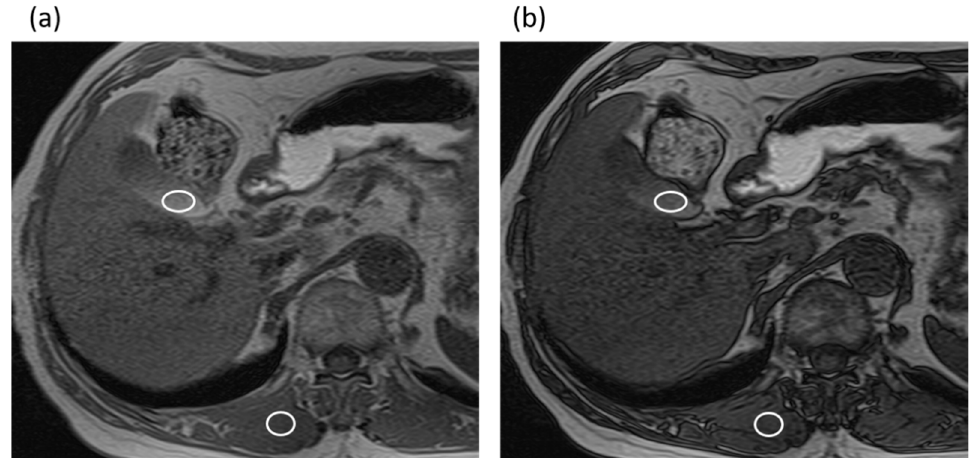
Figure 2. An 82-year-old man with intraductal papillary mucinous neoplasm in the non-gallstone group. ( a ) T1-weighted gradient-echo in-phase image. The gallbladder-to-muscle SIR was 2.12. ( b ) T1-weighted gradient-echo opposed-phase image. The gallbladder-to-muscle SIR was 1.72. The SRR of the gallbladder was